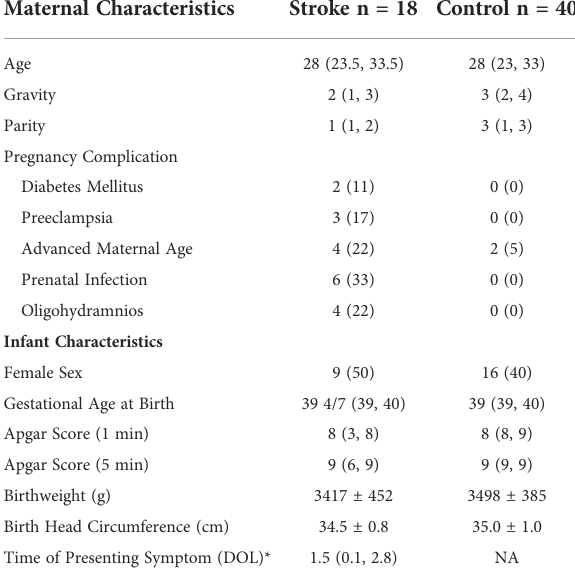
TABLE 1 Maternal and infant patient characteristics. Maternal